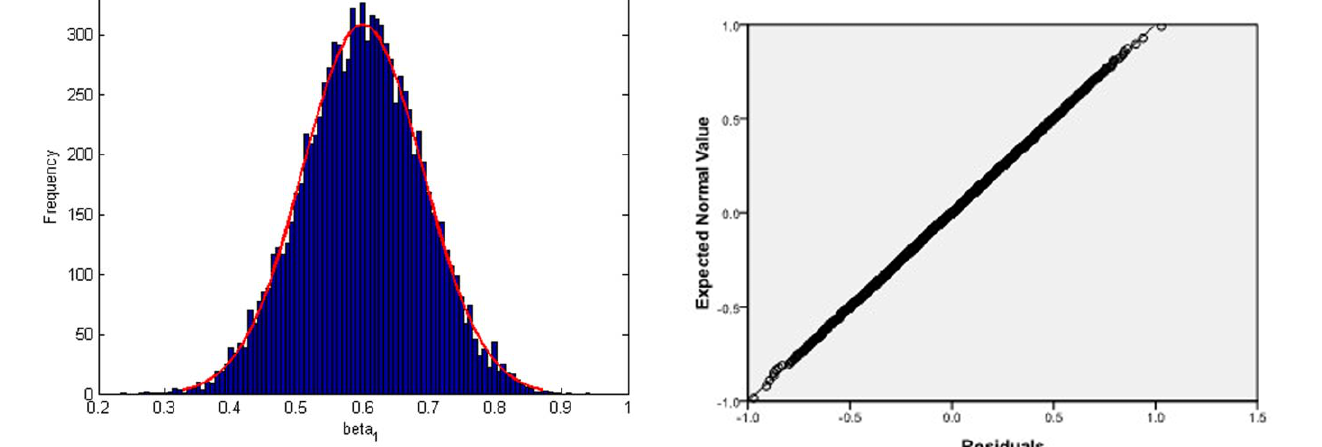
variance function of the error term is s 2 ( x 1 , x 2 ) ~ exp ( { ( x 2